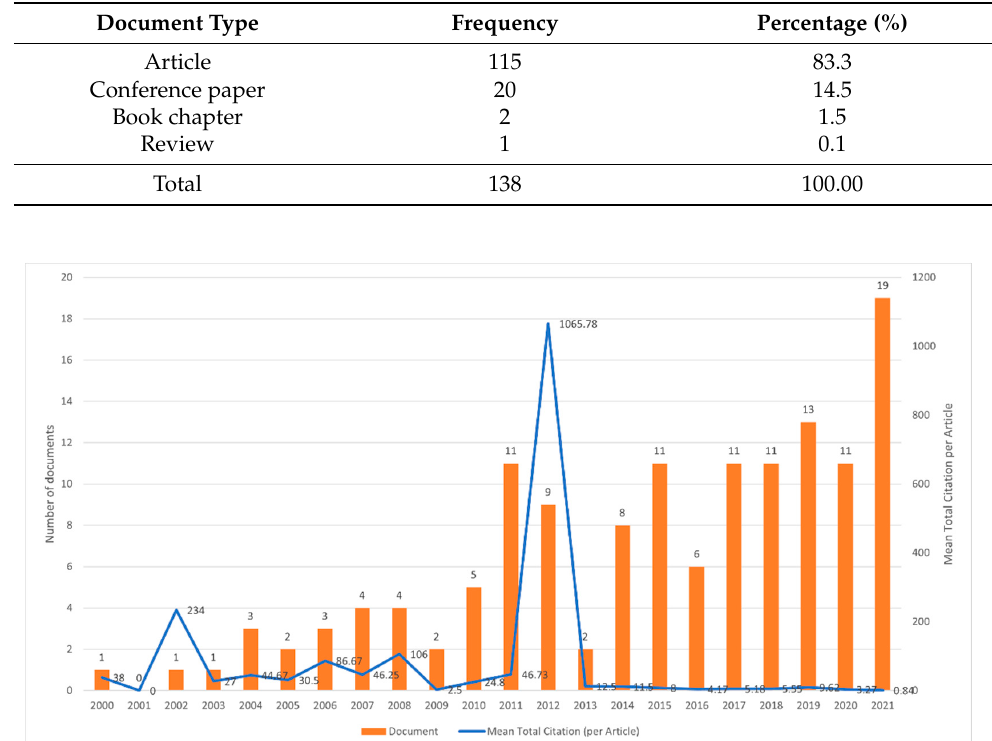
Figure 2. Evolution of publications on mortality forecasting and modelling from 2000 to